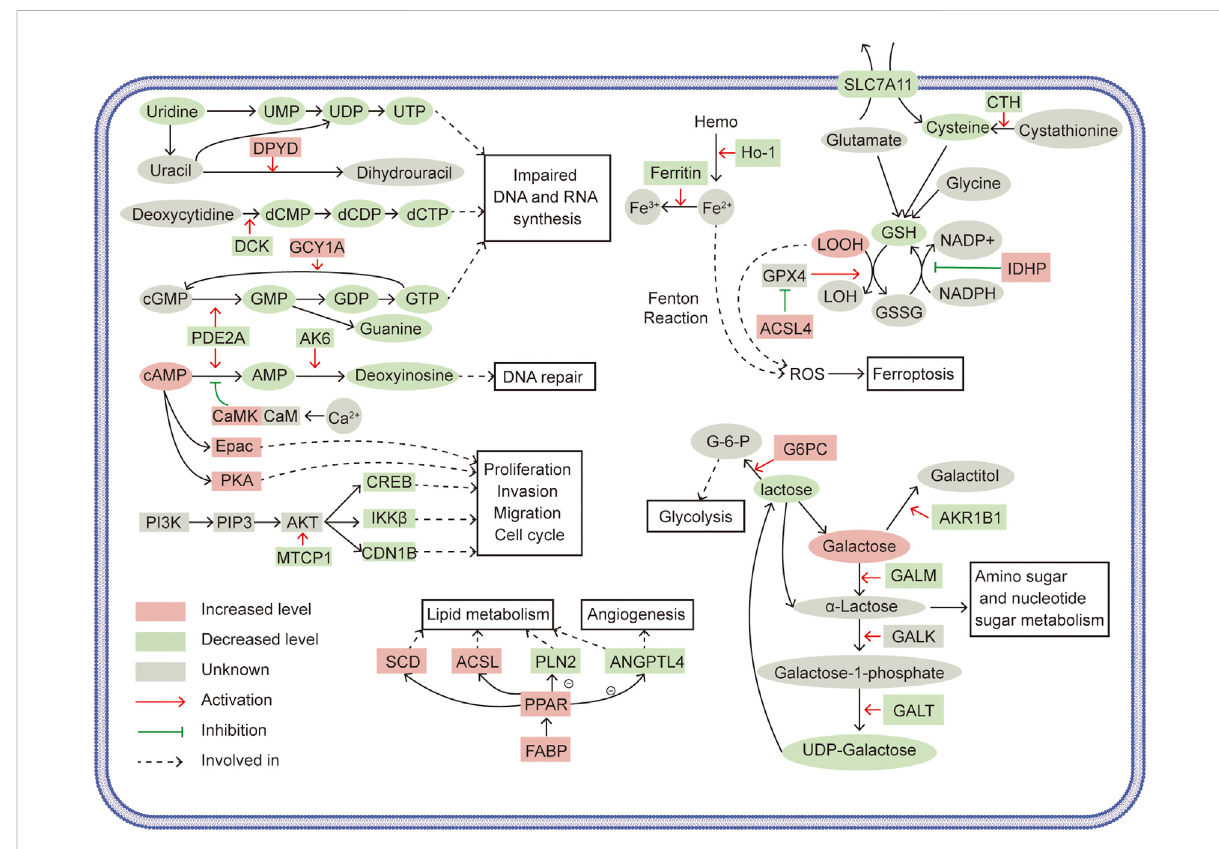
FIGURE 7 Schematics illustrating the tumor-suppressive mechanisms of SLC39A1. Ovals represent metabolites, squares represent related enzymes and regulatory proteins. Red indicates increased levels, green indicates decreased levels, and gray indicates temporarily unknown. Red arrows indicate activation, green arrows indicate inhibition, and black arrows indicate involved